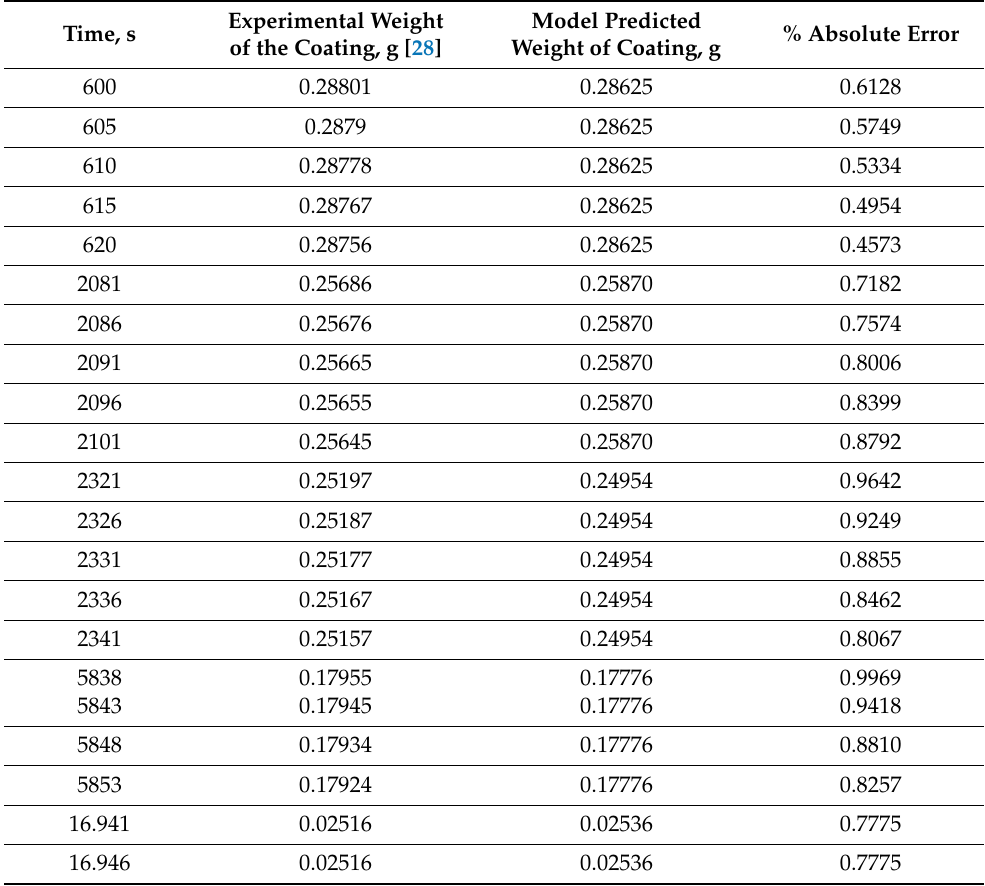
Table 5. Sample error between predicted and experimental values for 2009 µ m initial coating thickness with poly(styrene), p -xylene, and TPP contents of 4.99%, 93.01%, and 2.00%,